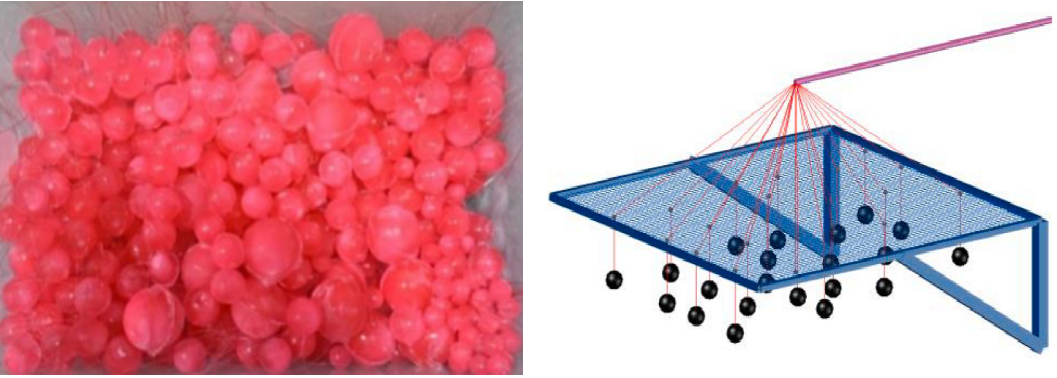
Figure 14. Experimental equipment for hail effect [75].